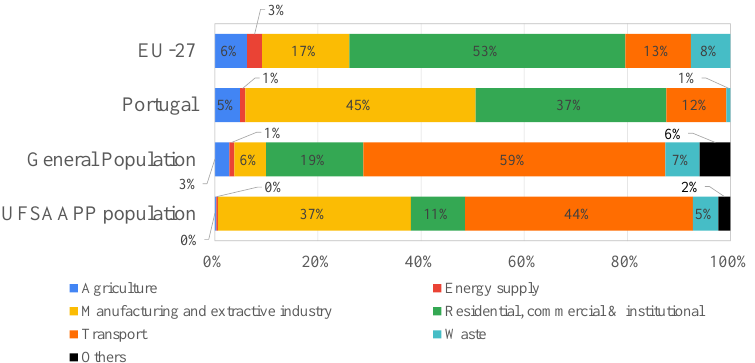
Figure 6. Emission sources of PM 2.5 in 2019 for EU-27 and Portugal [24], and the main air pollution sources perceived by the general and the UFSAAPP populations in the present study. The major differences between the official and real-world data regarding the PM 2.5 emissions sources (both from EU-27 and Portugal) and the sources identified by the two studied populations are: